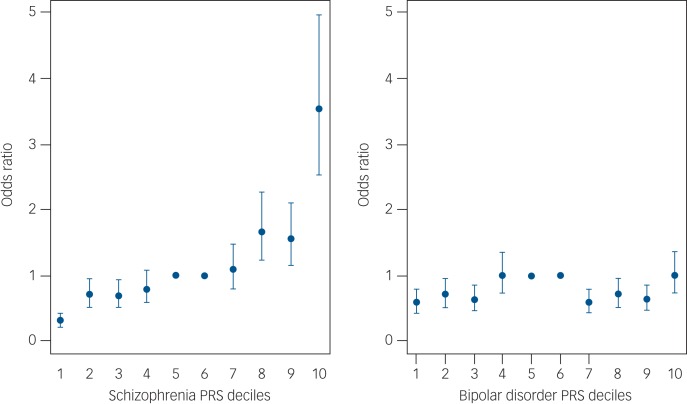
Odds ratio for broadly defined psychosis by risk polygenic score (PRS). The threshold used for selecting risk alleles was P-value threshold (PT) = 0.05. Based on PRSs, samples were allocated to deciles (decile 1, lowest PRS; 10, highest PRS). A dummy variable was created to compare the central deciles 5 and 6, used as reference to the others. Odds ratio and 95% CI were estimated using logistic regression including ethnicity principal components and cohort indicator as covariates. The points represent the odds ratios. The bars represent the lower and upper CI of the odds ratios.